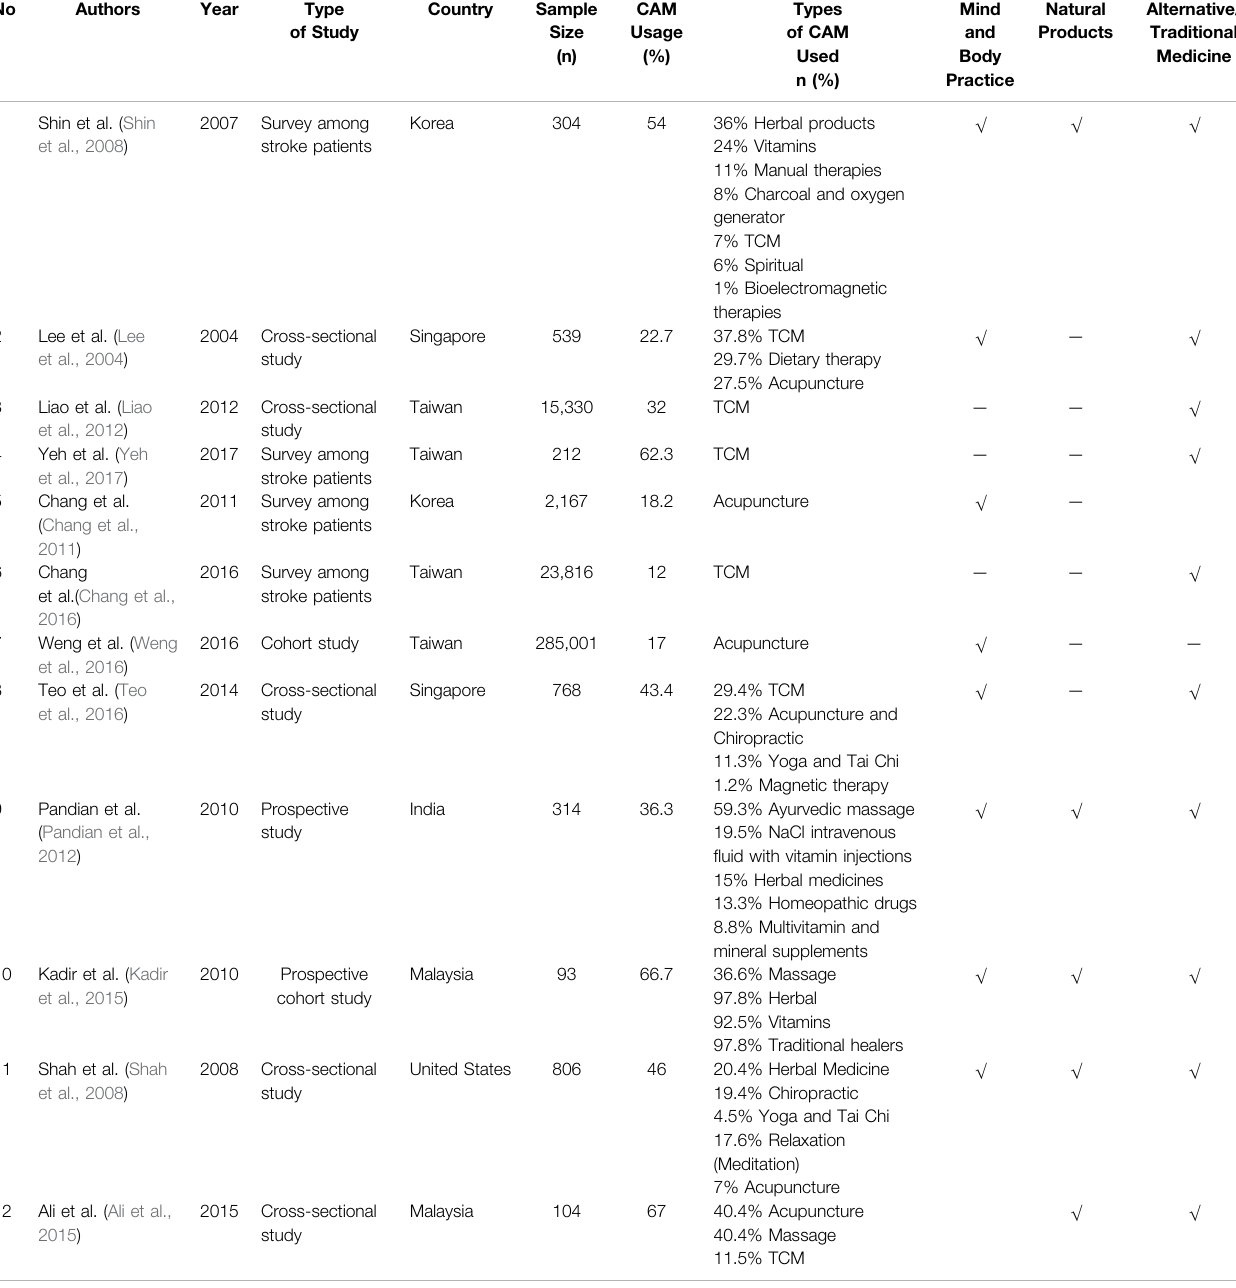
TABLE 2 | Prevalence and types of CAM